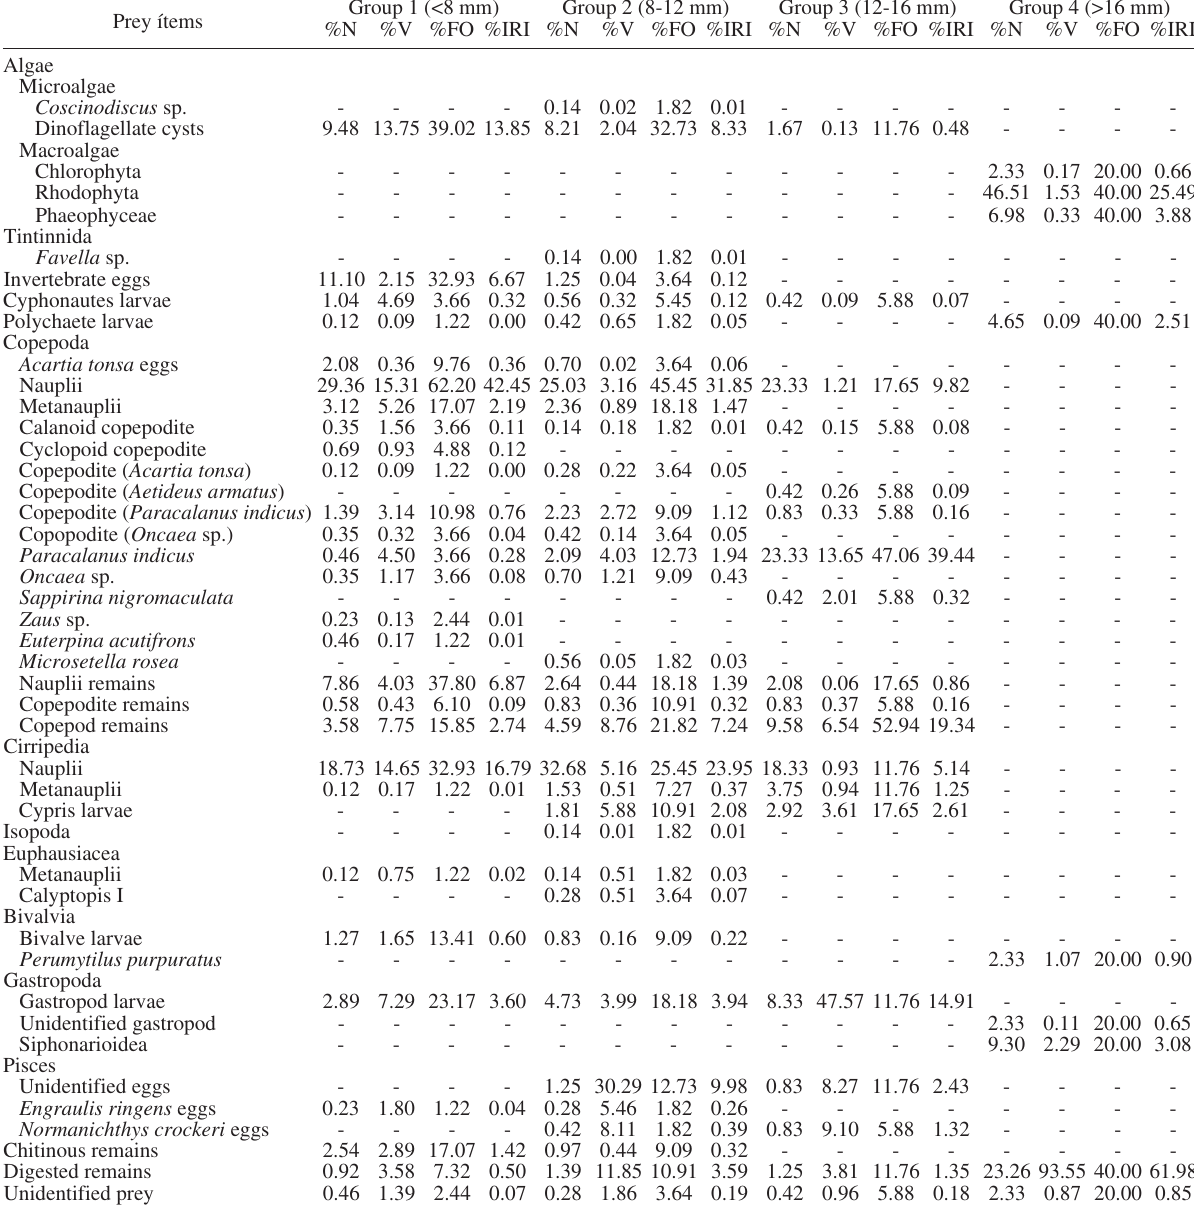
Table 4. – Diet composition of larval and juvenile clingfish Sicyases sanguineus by size groups. Prey ítems